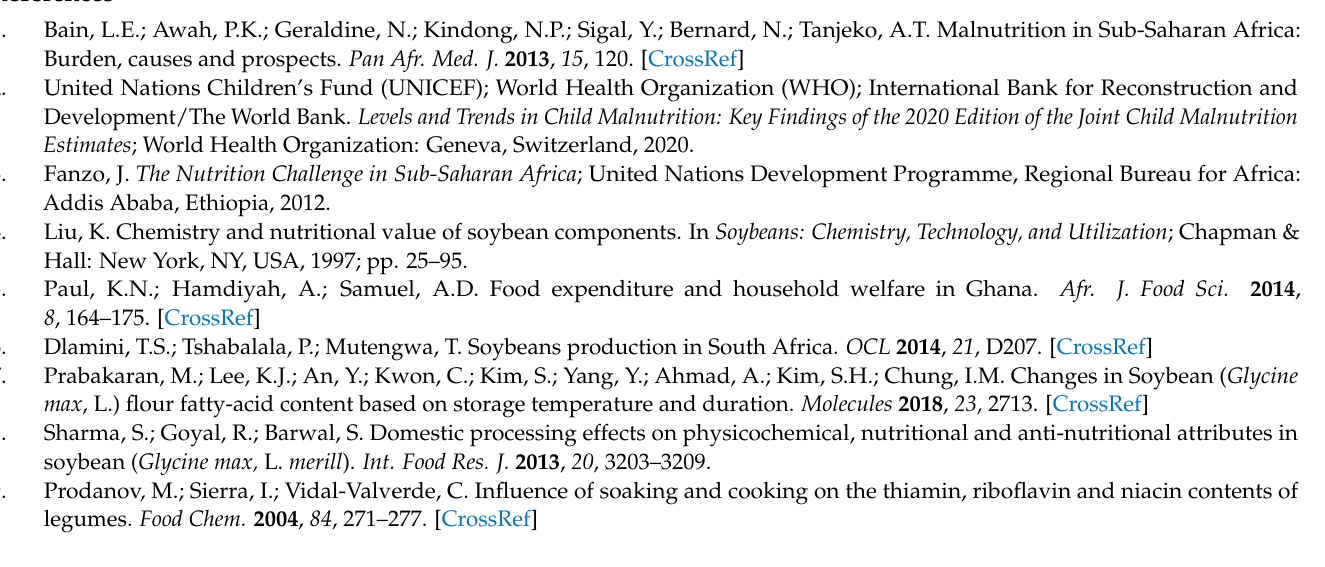
flow chart for the preparation of 1.5 kg Tuo Zaafi, Figure S2: preparation of Tuo Zaafi by women for sensory evaluation, Figure S3: sensory score for color of soy-enriched (n = 15), Figure S4: Sensory score for mouthfeel of soy-enriched (n = 15), Figure S5: sensory score for texture of soy-enriched (n = 15), Figure S6: sensory score for stickiness of soy-enriched (n = 15), Figure S7: sensory score for taste of soy-enriched (n = 15), Figure S8: sensory score for overall acceptability of soy-enriched (n = 15), Figure S9: crude oil yields of FFSF samples measured on day zero prior to the